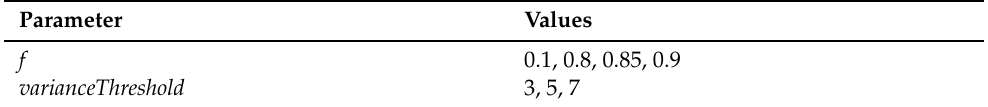
Table 5. Parameter list for f and varianceThreshold .